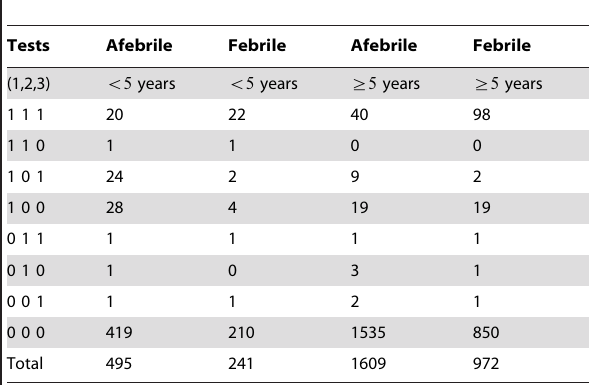
Table 1. Subsamples defined by the combination of age groups and fever status and observed frequencies of each pattern of test